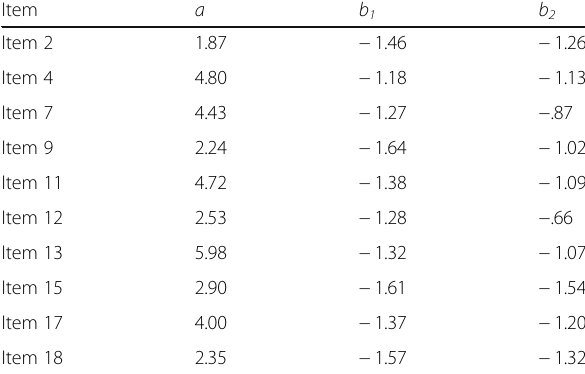
Table 4 GRM item parameter